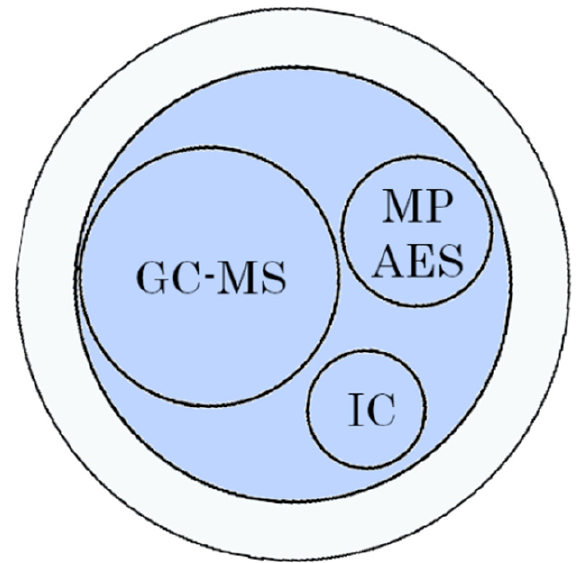
Figure 1. The 47 mm filter with 37 mm stain area and filter area apportionment scheme for GC-MS, MP-AES, and IC analysis.